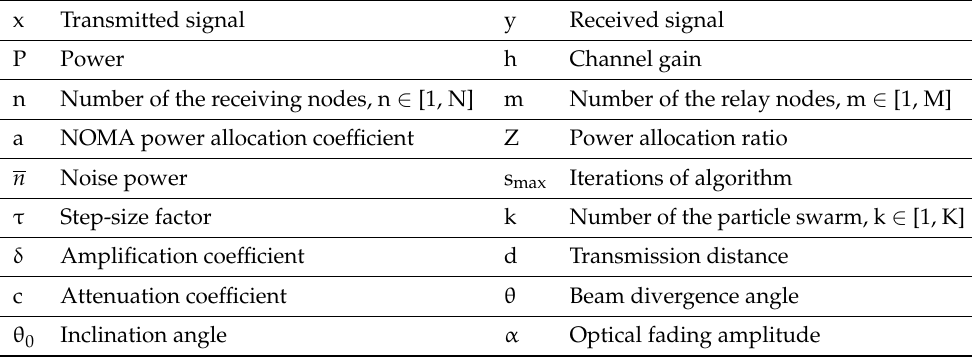
Table 3. Variables commonly used in this paper.